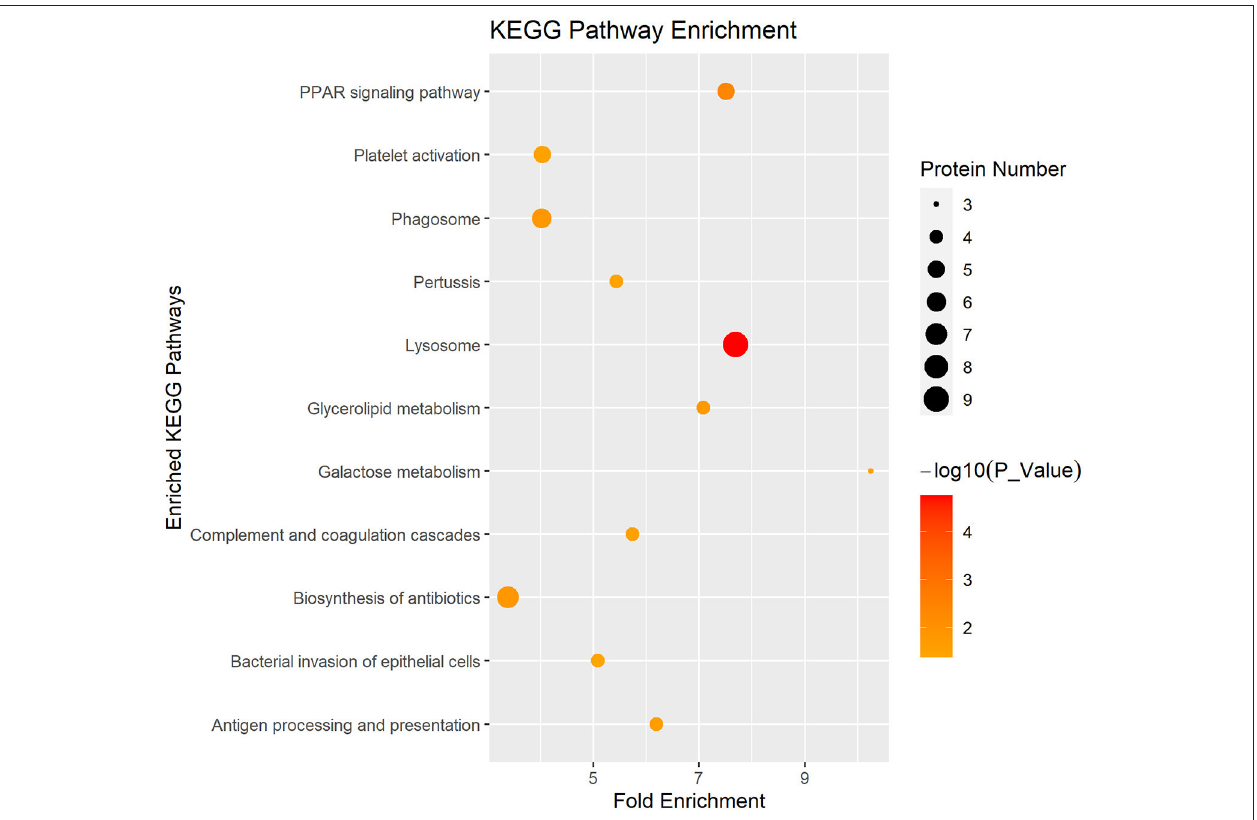
FIGURE 4 | Enriched KEGG pathway analysis of the DEP in DM and HM group. KEGG, Kyoto Encyclopedia of Genes and Genomes pathways; DEP, differentially expressed proteins; DM, donkey milk; HM, human